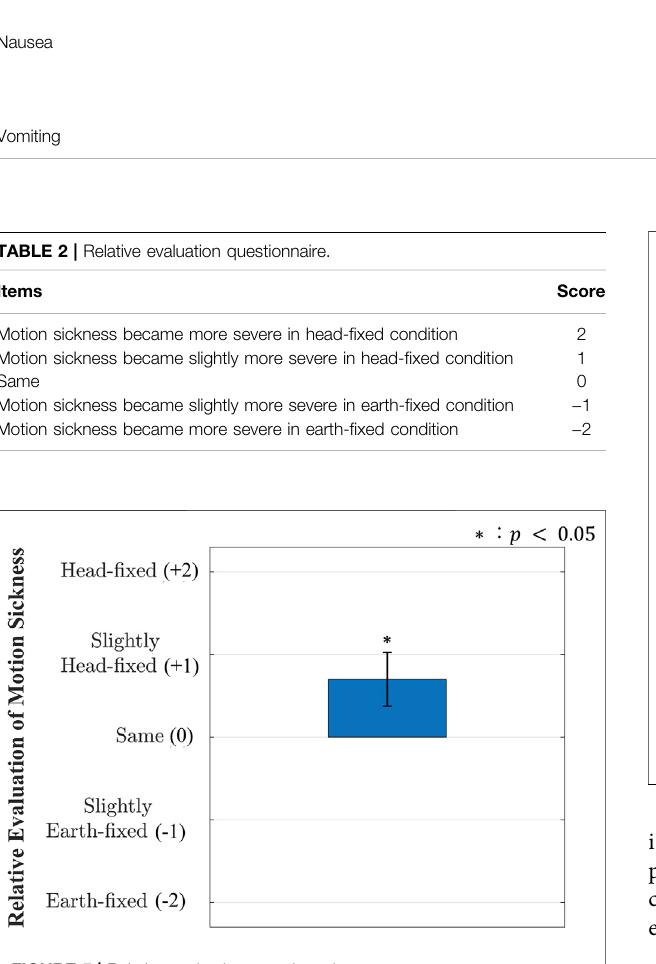
FIGURE 5 | Relative evaluation questionnaire.